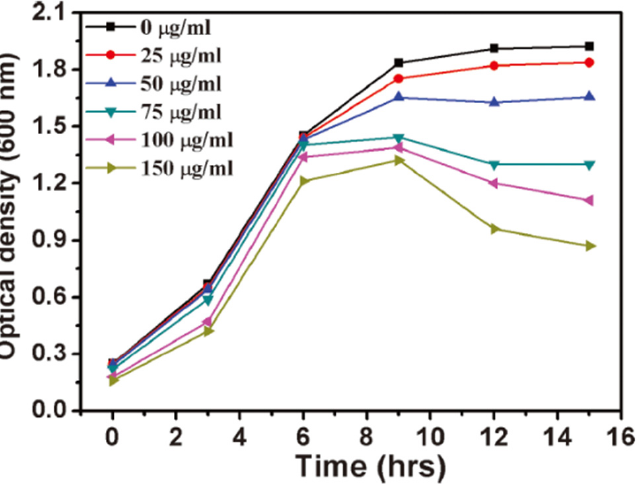
Figure 8. Bacterial growth curve of E . coli under different ZnO-NFs concentrations.